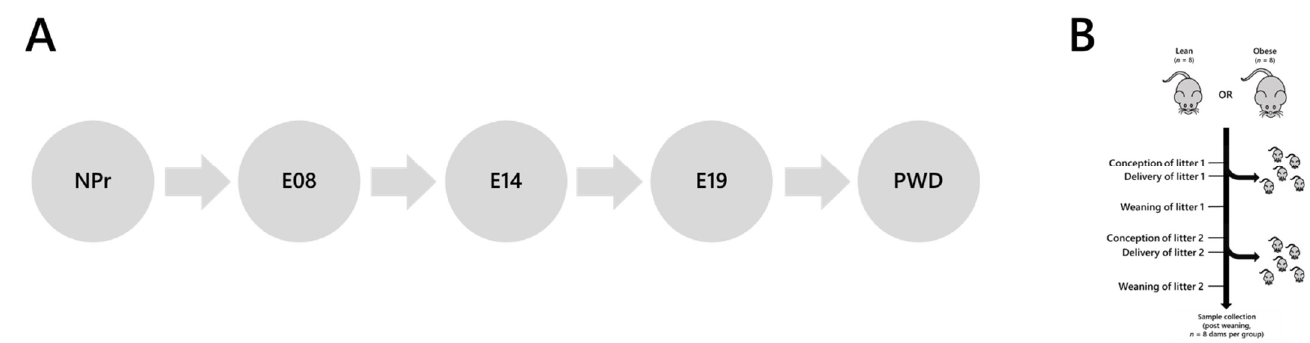
Figure 1. Mouse model and lipid collection points used in the present study. ( Panel A ) Collection time points used in the present study. ( Panel B ) Schematic representation of the mouse model used in this study [5–7]. NPr, not pregnant; E08, 8th day of pregnancy; E14, 14th day of pregnancy; E19, 19th day of pregnancy; PWD, post-weaning dam.